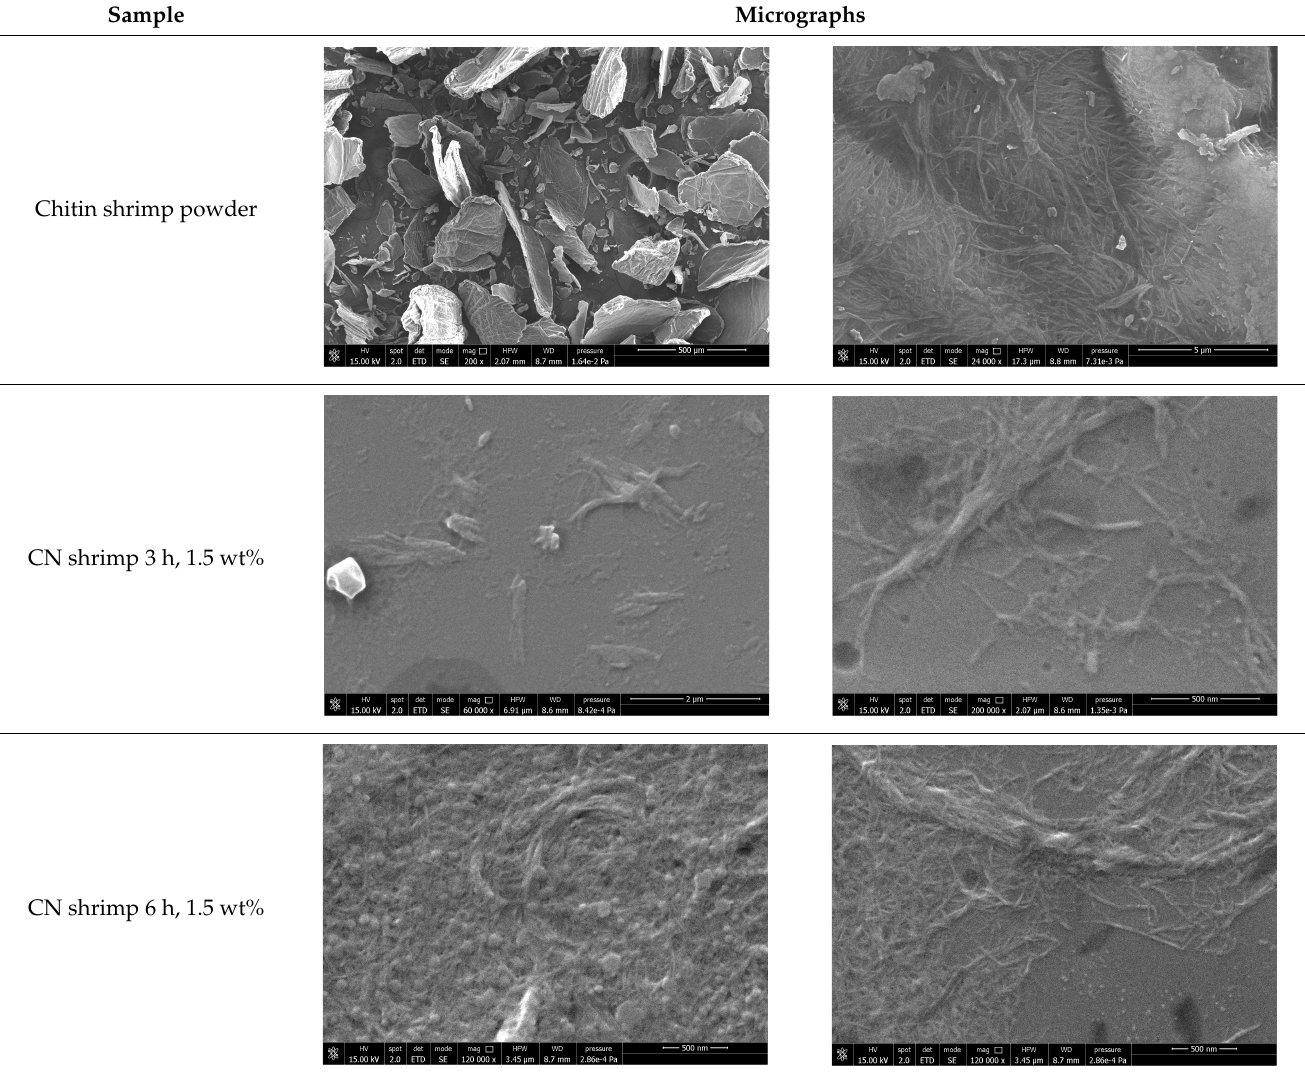
Table 2. Micrographs of chitin powder and CN suspensions from shrimps at different time and concentration.